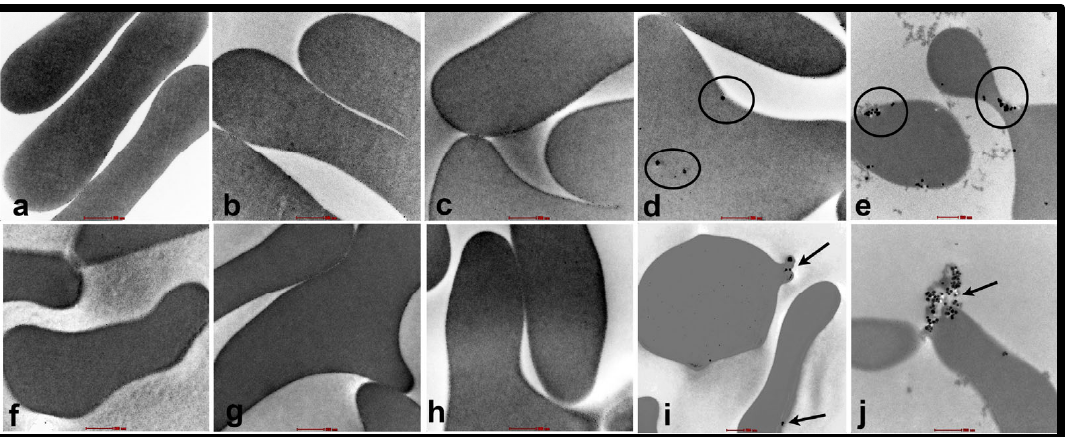
Figure 2. Transmission electron micrographs of the erythrocytes of normotensive (NT) (( a – e ): ( a ) NT ‐ saline; ( b ) NT 0.2; ( c ) NT 1:0; ( d ) NT 5.0; ( e ) NT 25 μ g/mL nanoparticles) and hypertensive (( f – j ): ( f ) HT ‐ saline; ( g ) HT 0.2; ( h ) HT 1:0; ( i ) HT 5.0; ( j ) HT 25 μ g/mL nanoparticles) rats after treatment with silica nanoparticles (SiNPs). A strong interaction between RBCs and nanoparticles were ob ‐ served after treatment with nanoparticles at a concentration of either 5 or 25 μ g/mL. The 50 nm SiNPs entered RBCs and caused destruction and eventual sloughing (arrow) of red blood corpuscles in HT rats ( i , j ). The extent of RBC damage is less severe after attachment of nanoparticles (empty circles) onto RBCs of NT rats. Scale bar = 2 μ m.